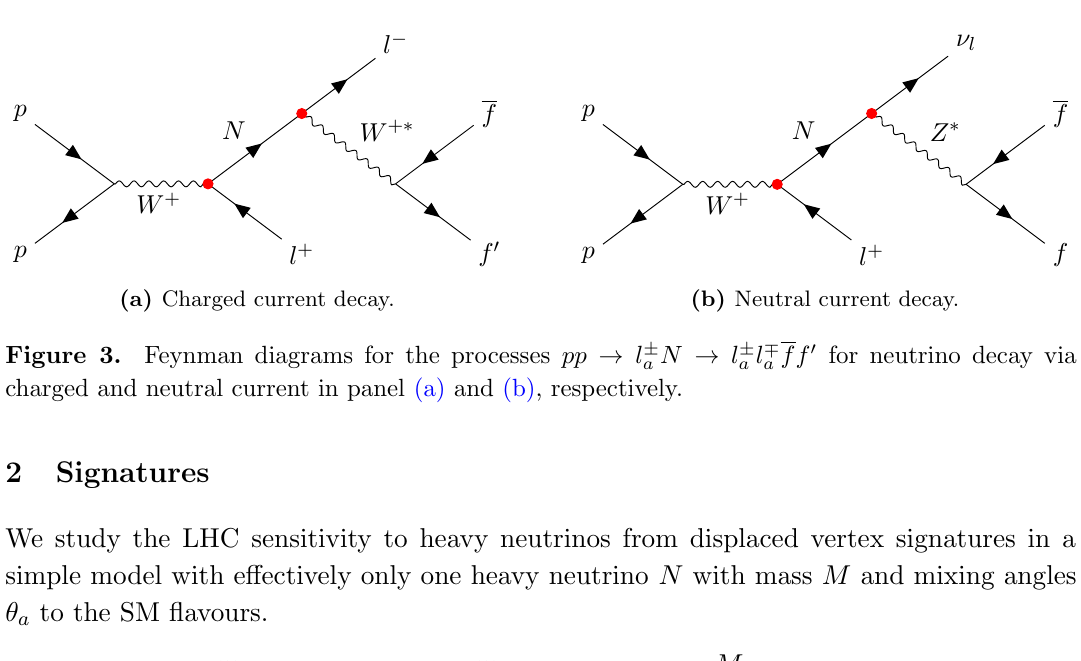
N ! l (cid:6) l (cid:7) ff 0 for neutrino decay via a a a